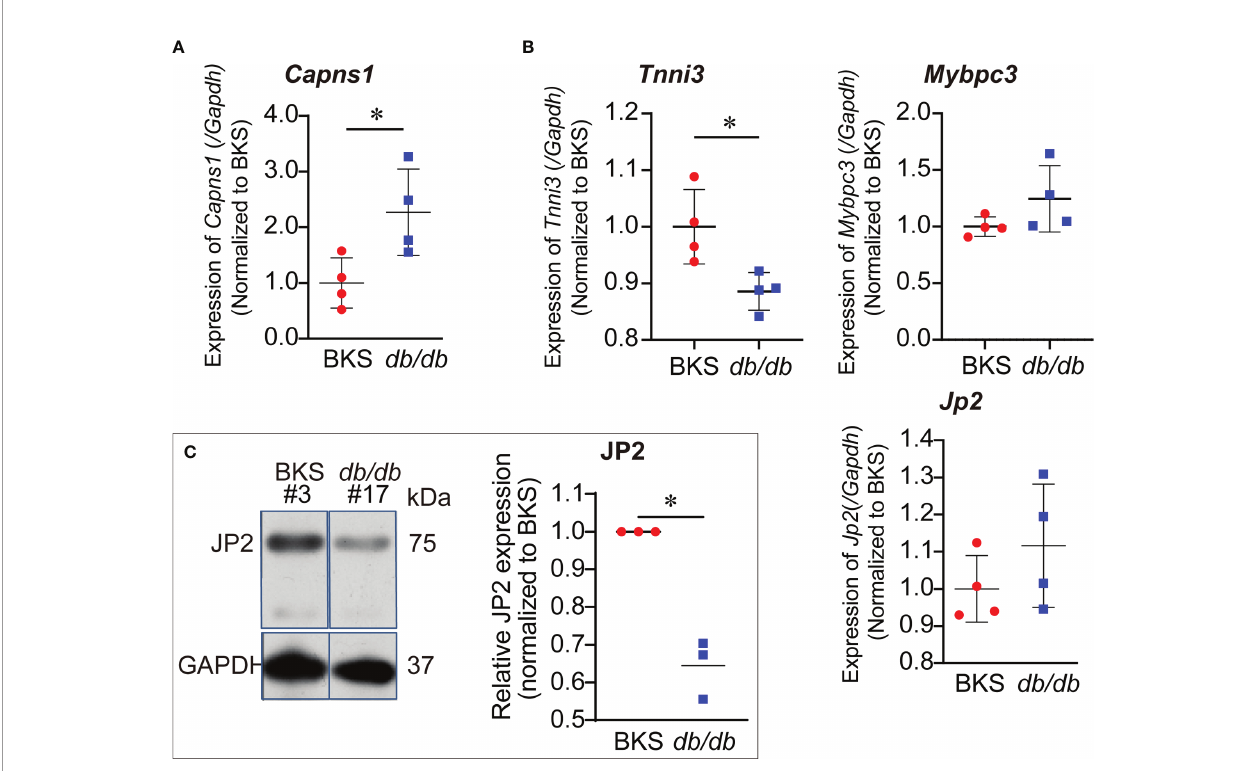
FIGURE 4 | Increased transcription of Capns1 in the hearts of db/db mice. (A) Cardiac Capns1 transcription enhanced in db/db mice (16-weeks-old). (B) The transcription levels of substrates Jp2 , Tnni3 , and Mybpc3 in cardiac calpain/CAPNS1 pathway were not reduced ( n =4, each sample was repeated three times). (C) Representative blotting showing JP2 protein decreased in expression in T2D hearts ( n =3, each sample was repeated three times, #3 and #17 were original lab codes of animals). * P <